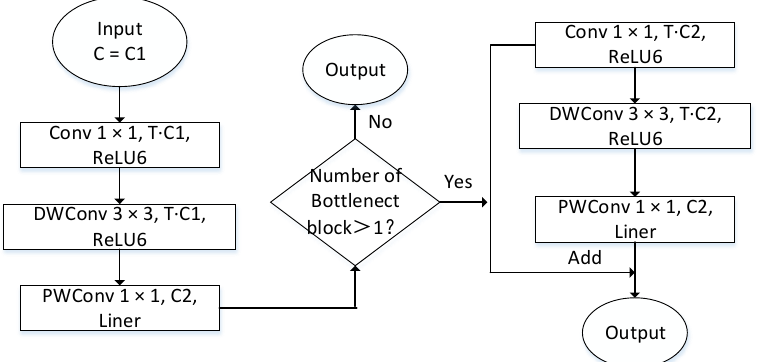
Figure 4. Bottleneck block structure of